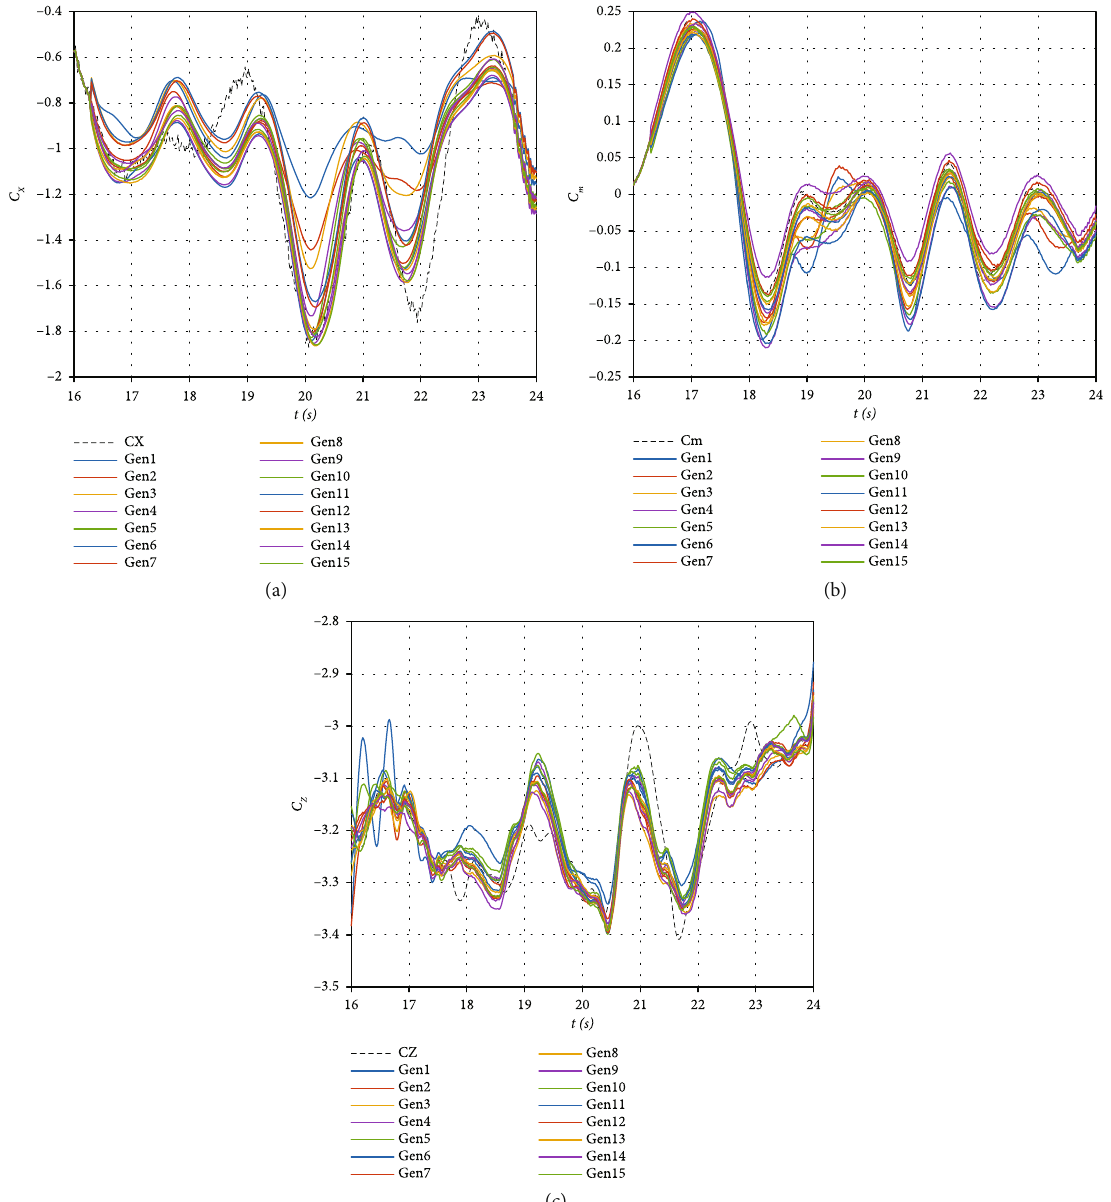
Figure 13: The GA results: (a) C